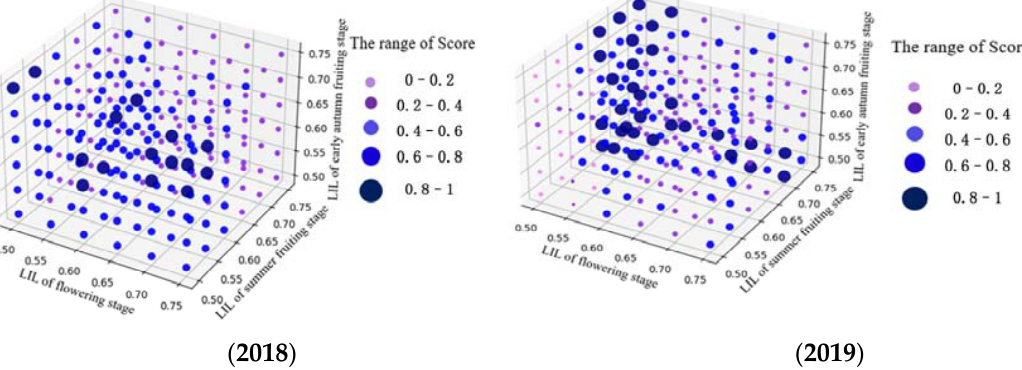
Figure 6. Scatterplot of relationship between lower irrigation limit and score at different growth stages (LIL means lower irrigation limit).